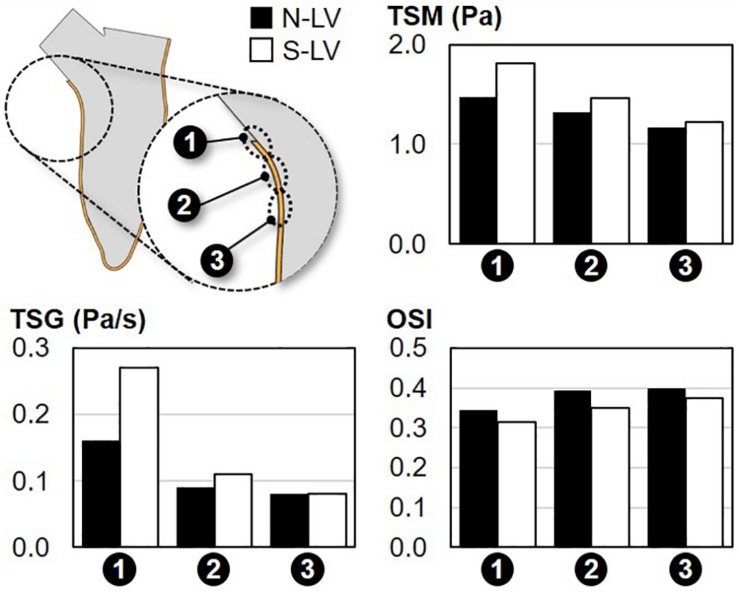
Comparison of the TSM, TSG and OSI on the septal wall of the N-LV and S-LV models (site 1: immediately above the septal wall crest; site 2: septal wall crest; site 3: immediately below the septal wall crest).